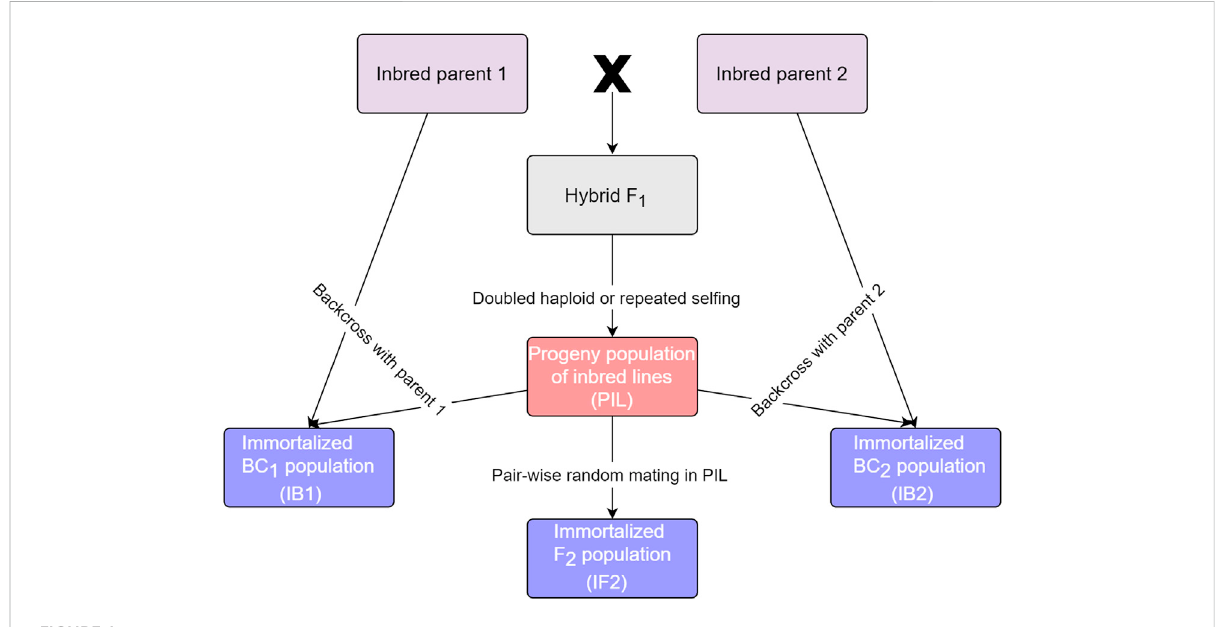
FIGURE 1 Relationship between populations that can be handled in